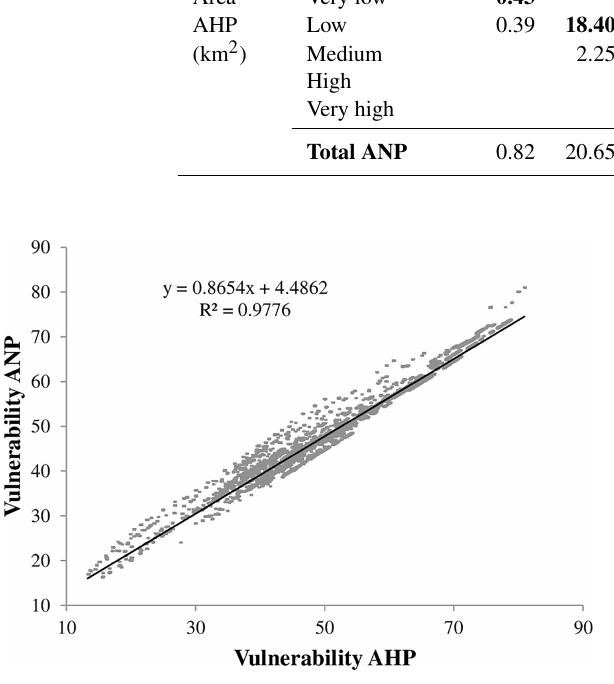
Figure 6. Correlation of the ANP and AHP flood vulnerability maps